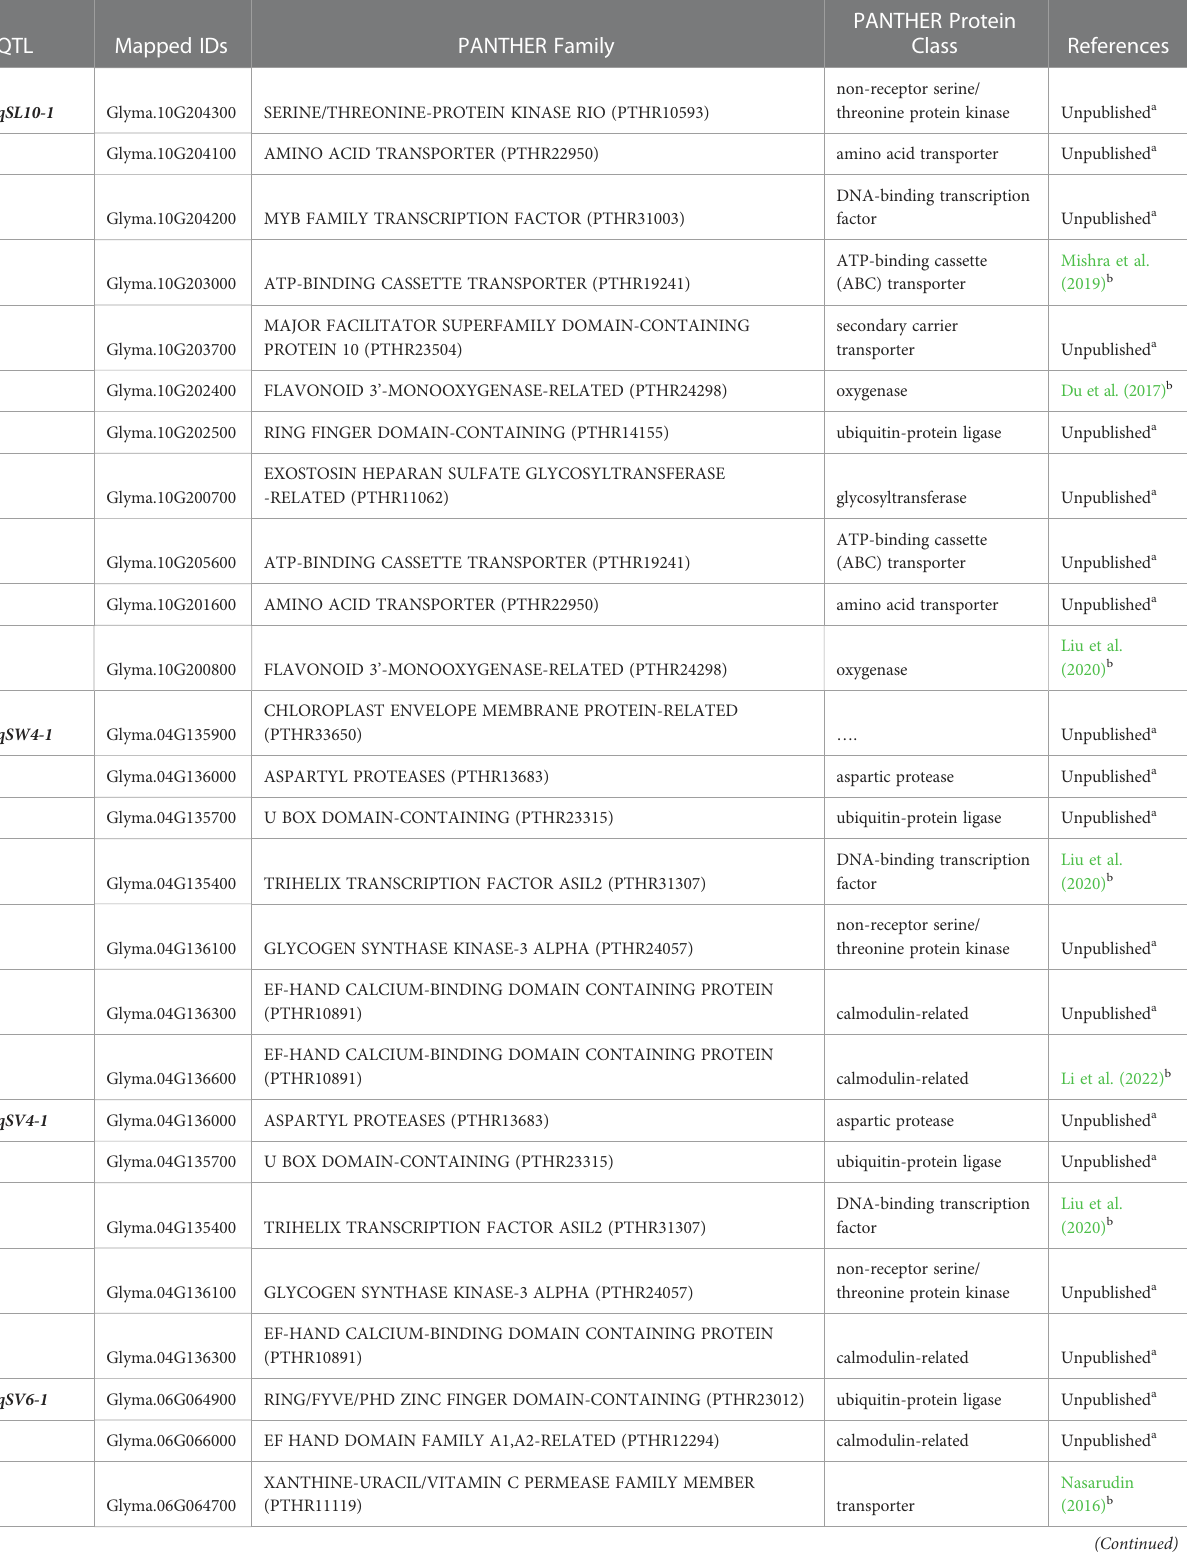
TABLE 6 Sixty-six possible candidate genes predicated within seven stable QTL regions identi fi ed in this study based on PANTHER analysis, gene annotation, and available literature.